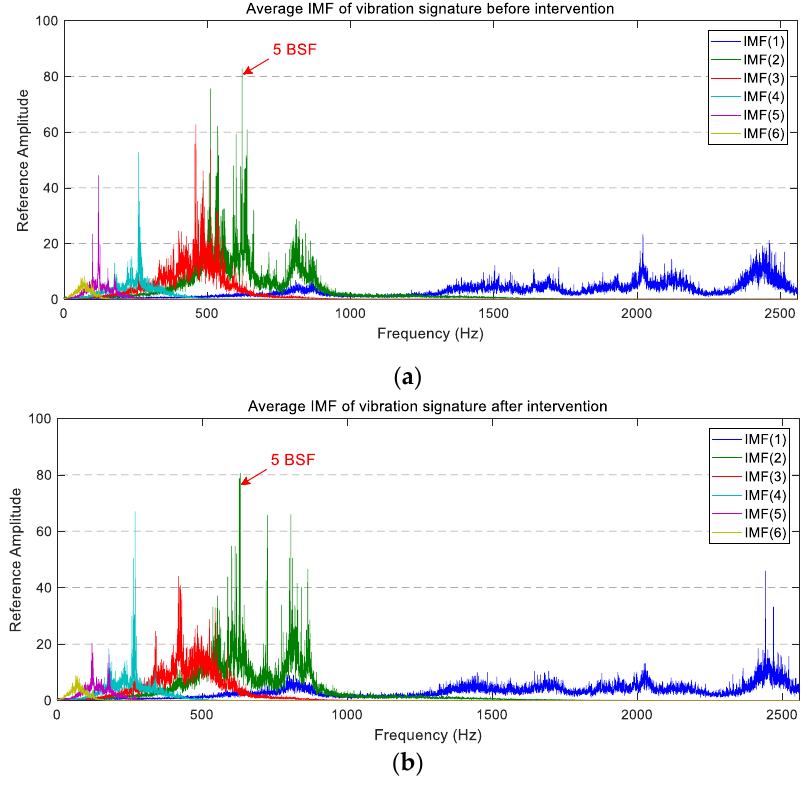
Figure 11. The average PSD of the IMFs corresponding to the axial vibration signals: ( a ) before maintenance; ( b ) after maintenance.